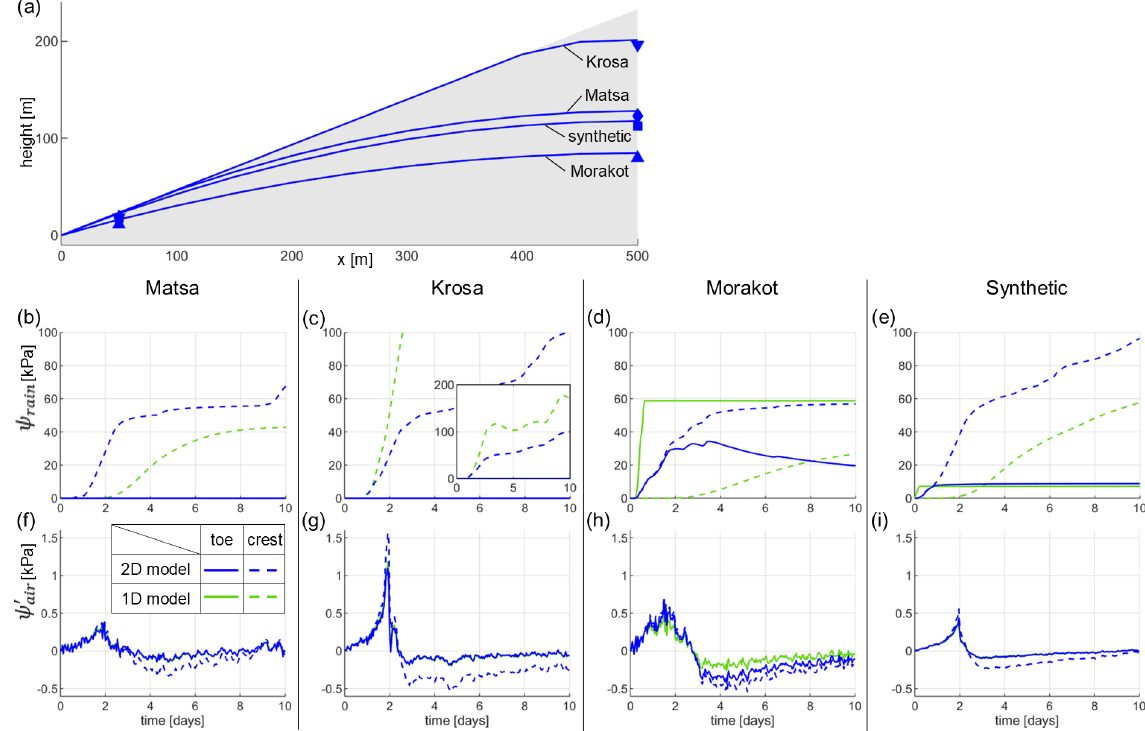
Figure 6. Initial state of the water table in the hillslope (a) before each typhoon, for a diffusivity of 10 − 2 m 2 s − 1 . Markers indicate the location of investigated points in the following figures (b–i) , 5m under the initial water table both at the crest and the toe of the hillslope. (b–e) and ψ rain (f–i) in response to the four typhoons using the hillslope model (blue lines). Solid and dashed The temporal evolution of ψ (cid:48) air lines represent atmospheric and rainfall effects at the toe or crest of the hillslope, respectively. The solid and dashed green lines represent the equivalent to the blue ones, computed using the 1D infinite slope model described in Sect. 5.1, at similar